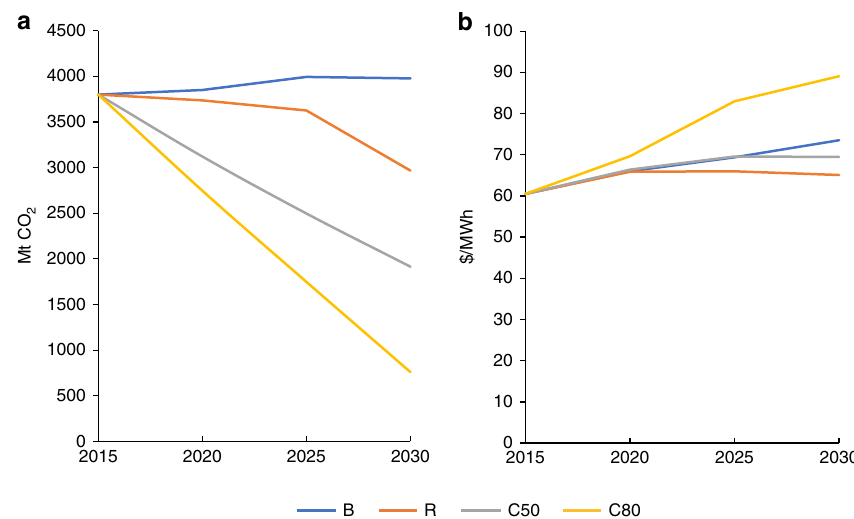
Fig. 4 Carbon emissions and power costs to 2030 under four scenarios. a Carbon emissions and b Power costs are shown in the business as usual scenario (B), the low-cost renewables scenario (R), the carbon constraints scenario (C50), and the deep carbon constraints scenario (C80), respectively. Power costs in the R scenario and the C50 scenario are 11% and 6% lower than that of the BAU scenario in 2030, respectively. Source data are provided as a Source Data fi le.